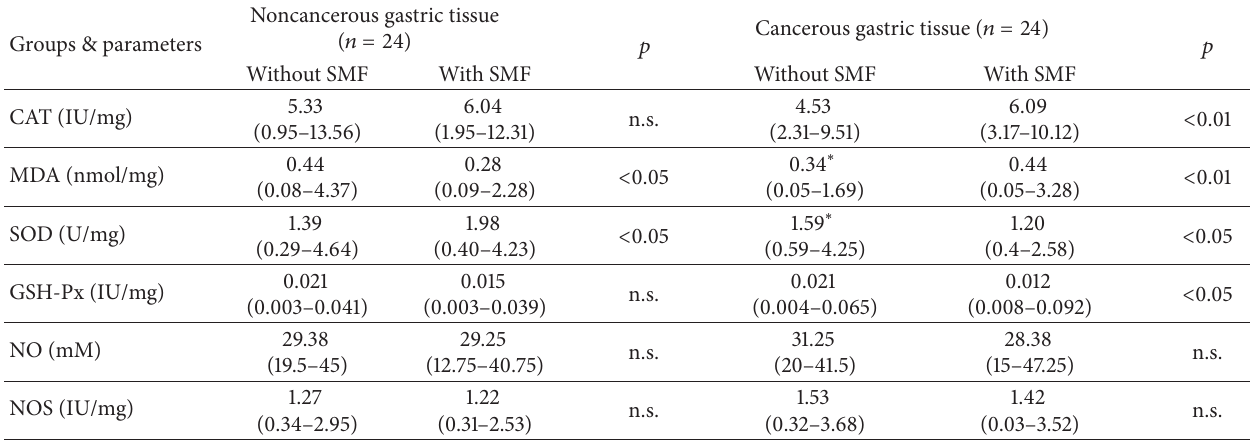
Table 1: Median (min–max) values for oxidant/antioxidant parameters in cancerous and noncancerous gastric tissues with SMF and without